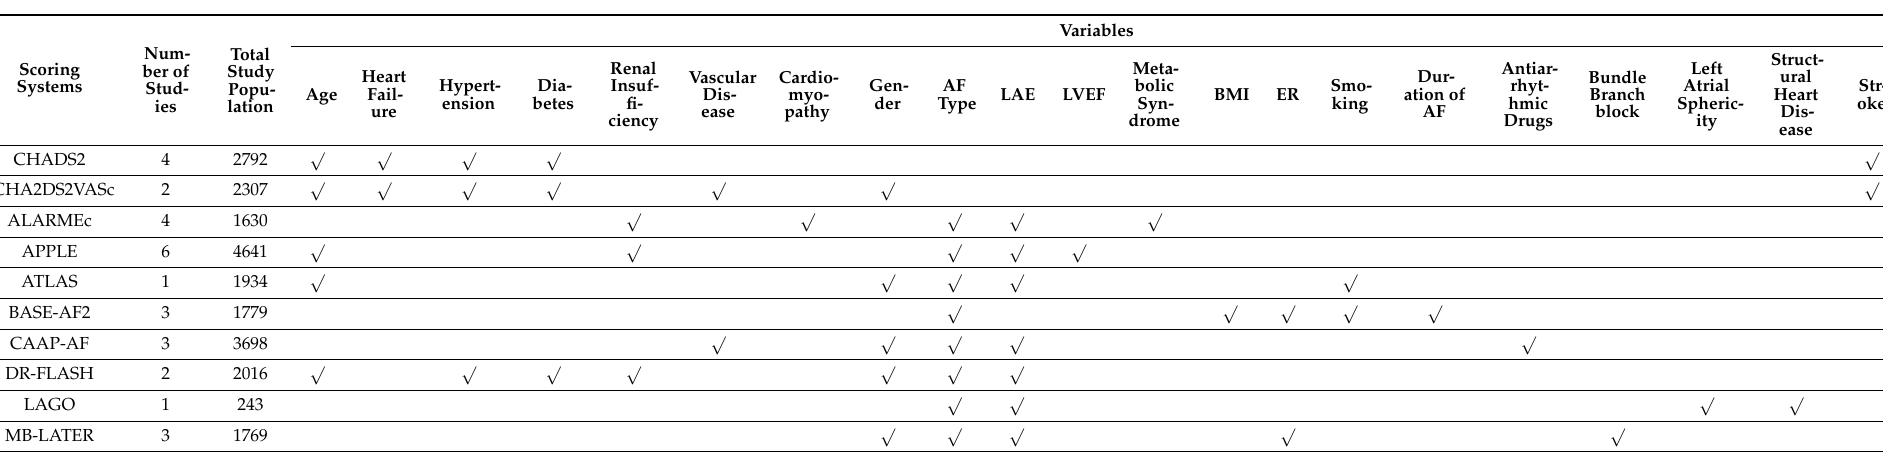
Table 1. Definitions of Different Scoring